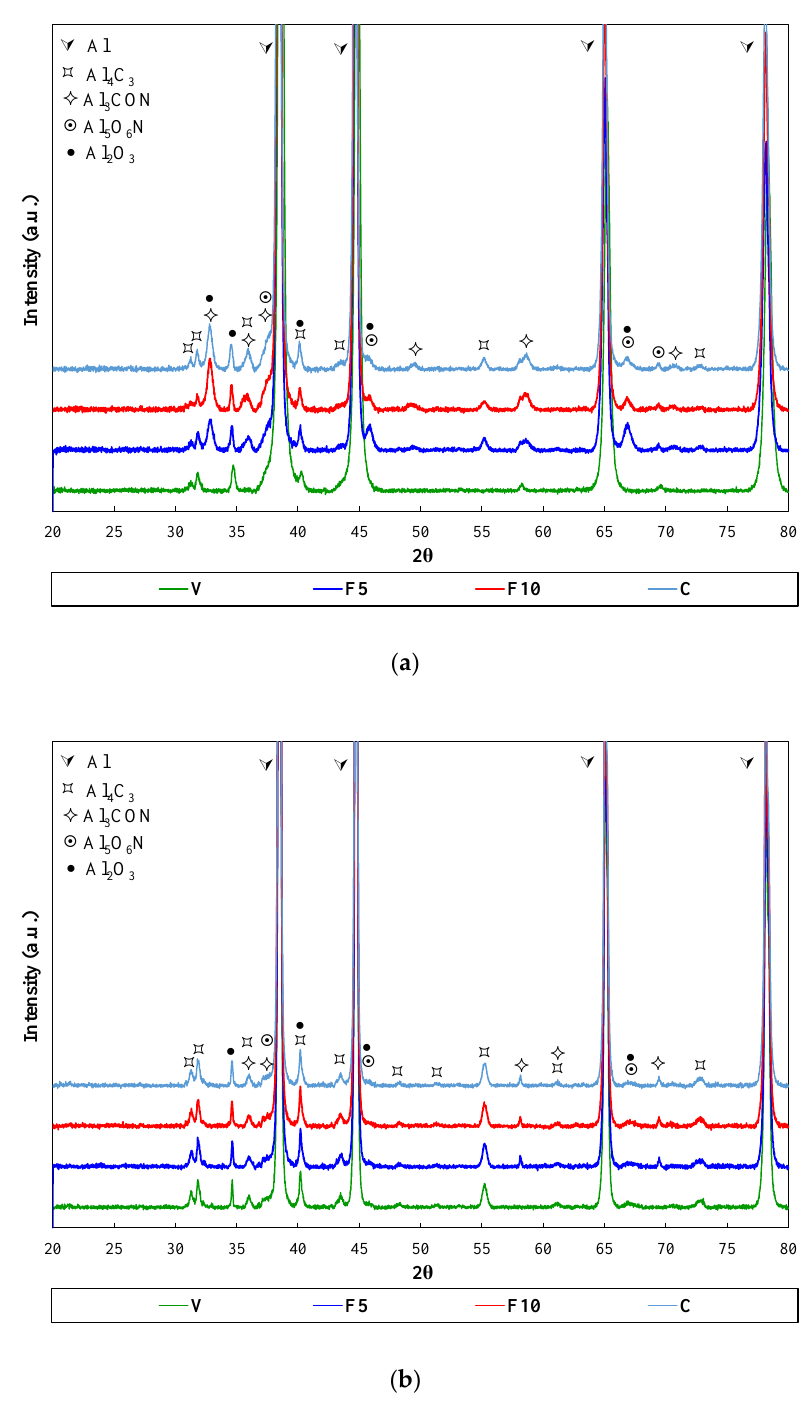
Figure 2. XRD patterns of the different samples after being ( a ) sintered and ( b ) heat treated at 400 °C for 100 h.